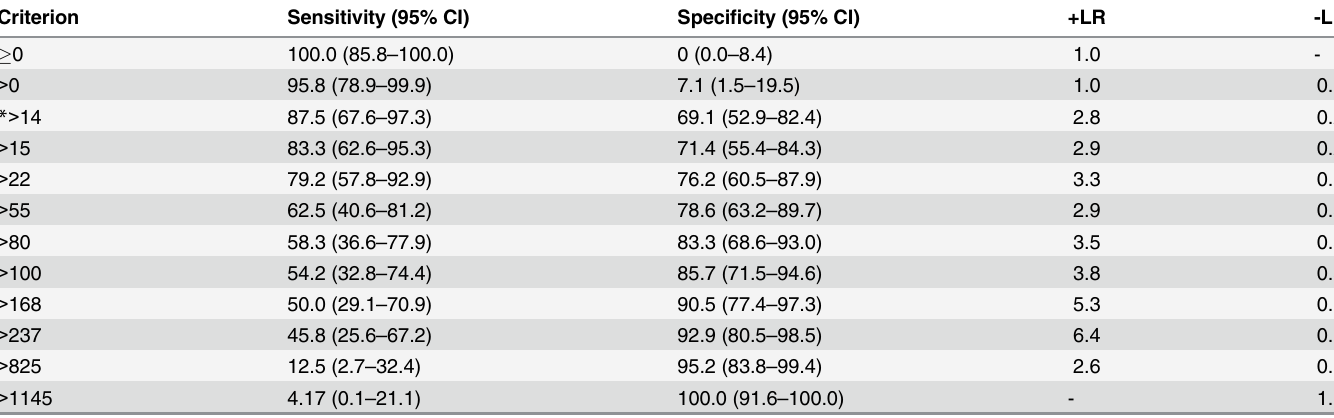
Table 3. Predictive value of CEACAM6 in cholangiocarcinoma by various cut-off criterion. Criterion